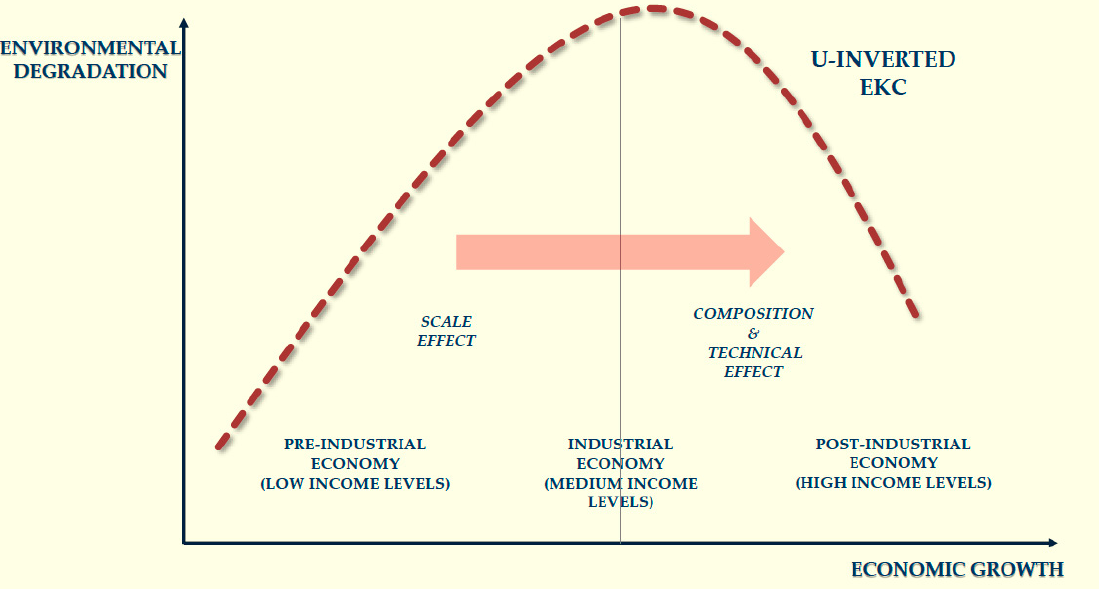
Figure 1. The traditional inverted-U EKC.